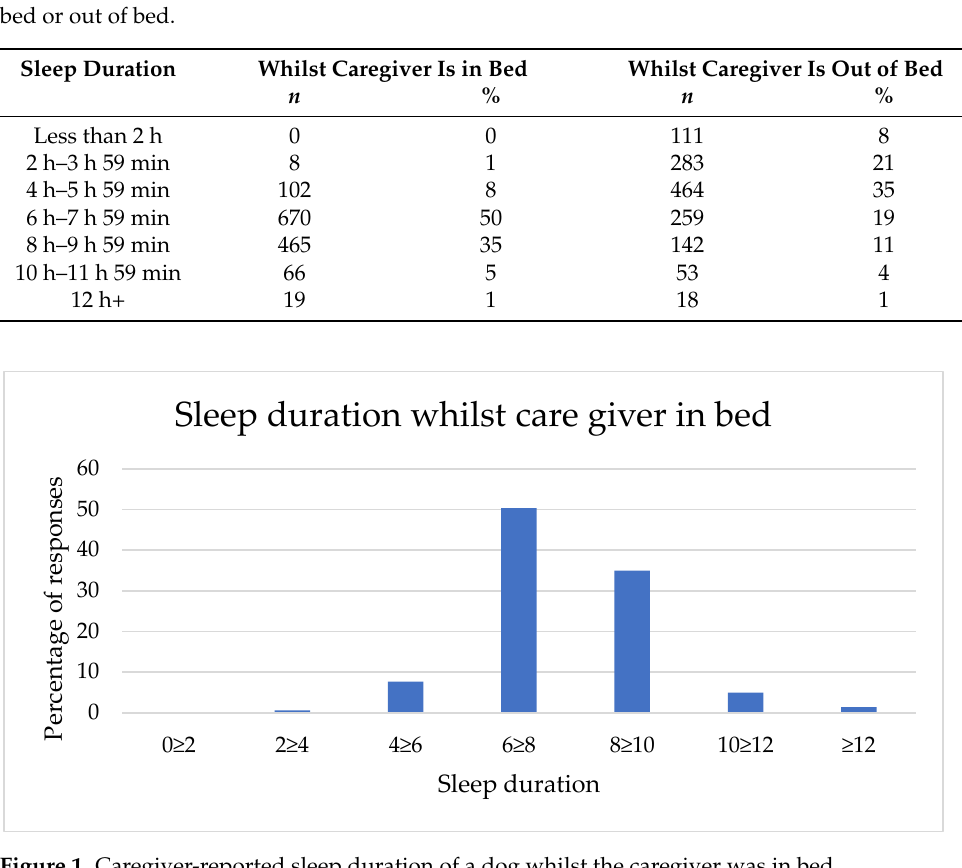
Figure 1. Caregiver-reported sleep duration of a dog whilst the caregiver was in bed.